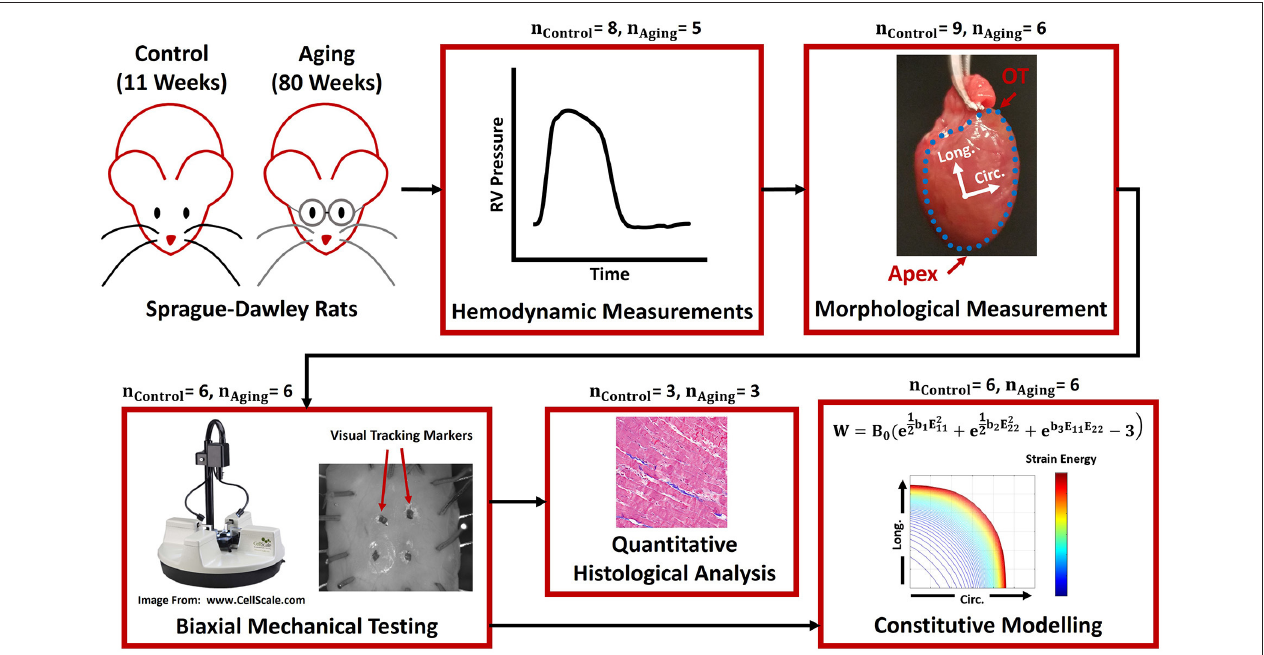
FIGURE 1 | The framework used to study RV remodeling with healthy aging. In vivo terminal invasive hemodynamic measurements were performed on young controls and aging Sprague-Dawley rats, followed by harvesting the heart and morphological measurements, biaxial mechanical testing, constitutive modeling, and quantitative transmural histological analysis. The blue dots in the “Morphological Measurement” panel demonstrate the boundaries of the RV free wall, while the Circ-Long coordinate system indicates the orientation of square specimens harvested for mechanical testing. RV, Right ventricle; OT, Outflow tract; Circ, Circumferential; Long,